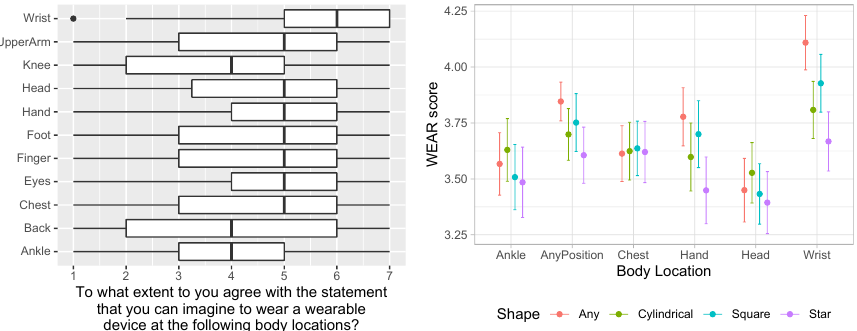
Figure 3. ( left ) Box plot with the ratings of the participants regarding to what extent they can imagine wearing mobile devices on other parts of their body. ( right ) Mean ratings on the WEAR v.3 scale on the individual conditions. The ratings indicate that the wrist seems to work out for the participants, and, in particular, the participants are likely to accept any device placed at wrist, while star-shaped devices attain the lowest acceptance ratings throughout the